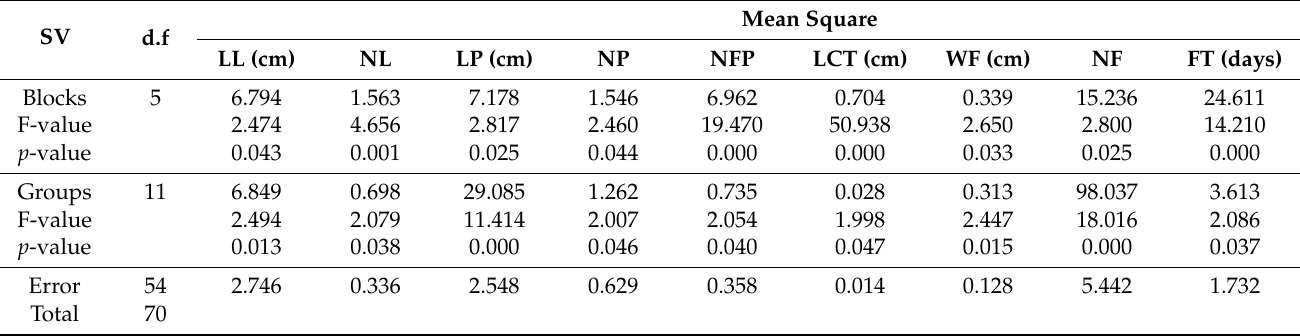
Table 1. The sources of variation and mean squares values of blocks and groups for nine morphologi- cal characteristics for ”Natalie” and ”Bristol’s Gum Drop” parents and their F 1